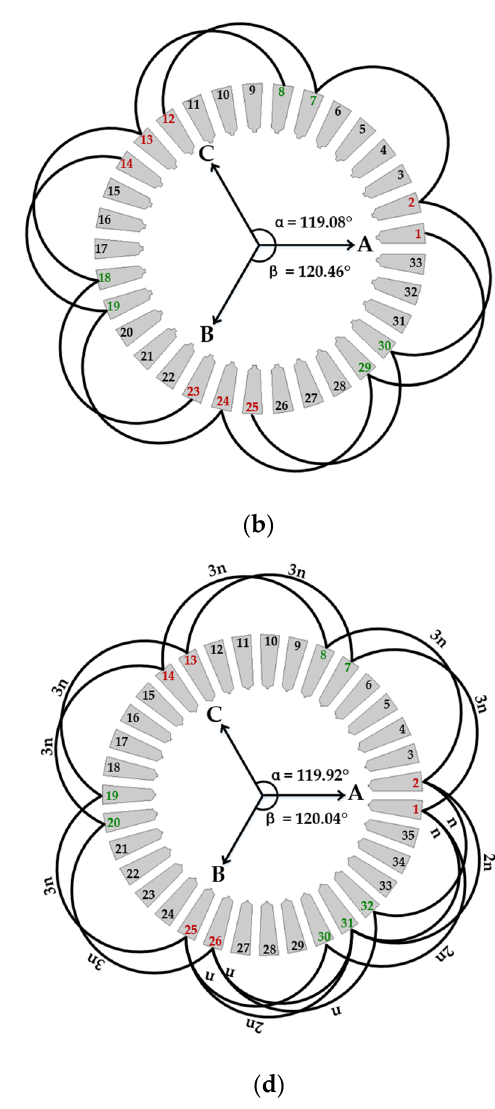
Table 11. Slot distribution to phases of M 4 .